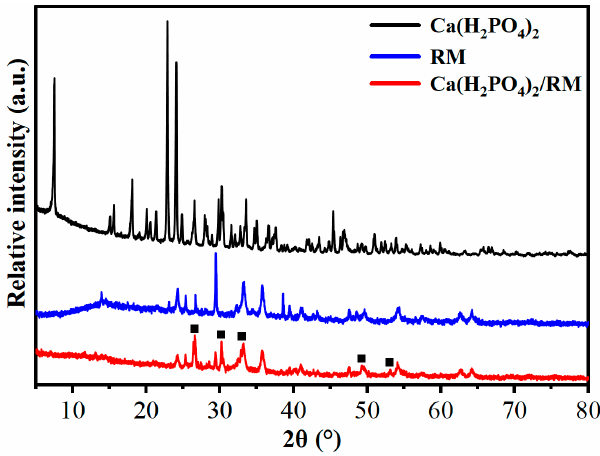
Figure 4. XRD patterns of explosion suppressants.